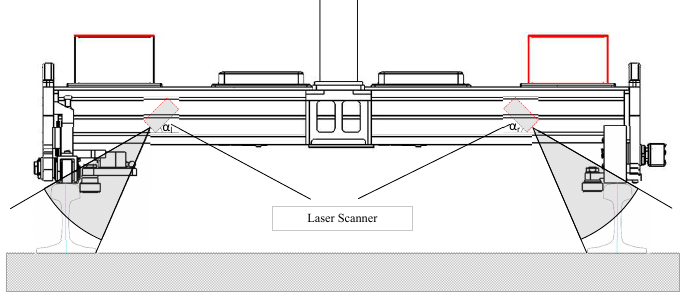
Figure 5. System